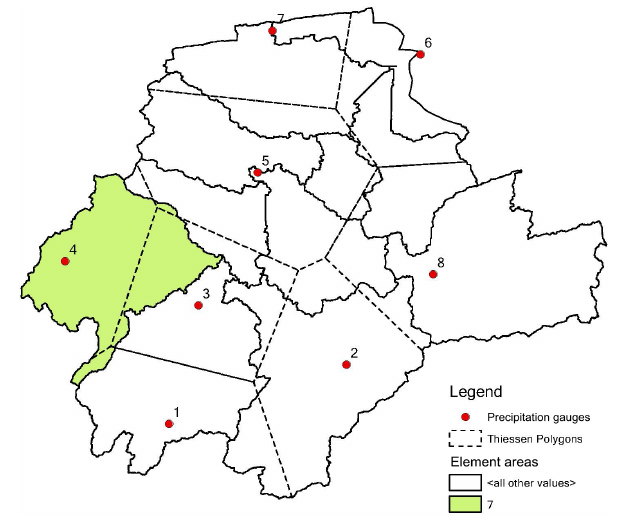
Figure 4. Sketch plot of precipitation calculation based on element areas and Thiessen